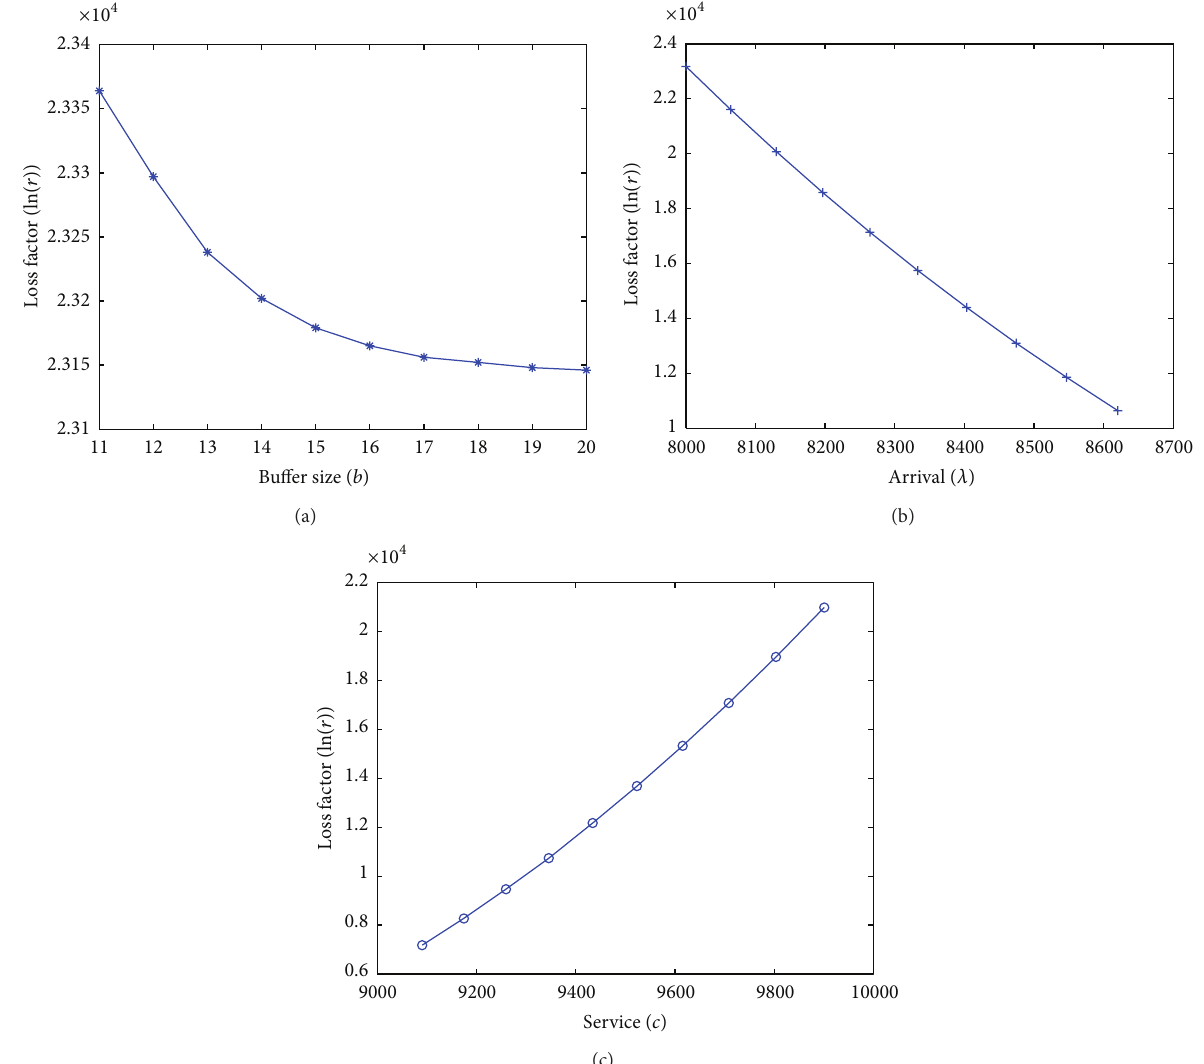
Figure 5: Curves between the loss factor and the buffer size, the loss factor and the arrival rate, and the loss factor and the service